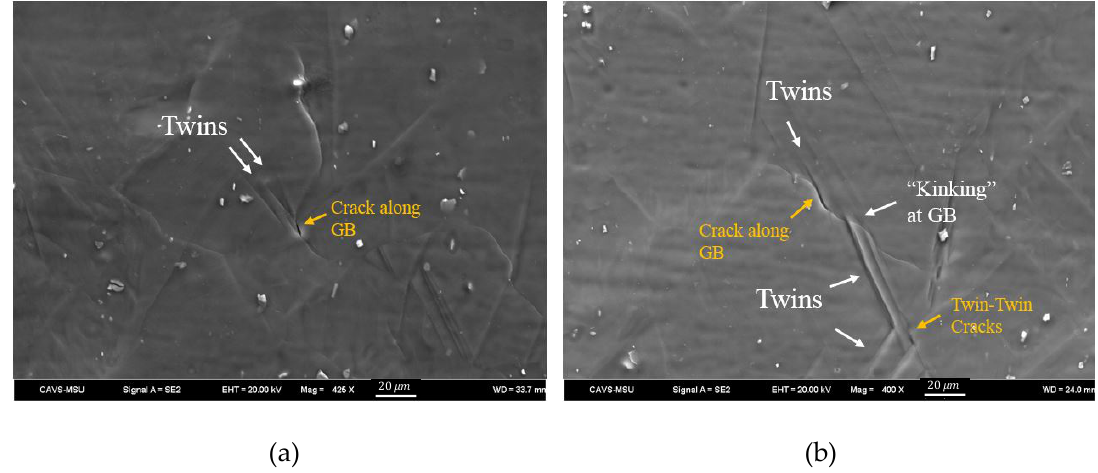
Figure 8. ( a ) Twin–grain boundary (GB) interactions leading to crack nucleation due to a lack of strain accommodation. ( b ) Proper accommodation of strain is found at the surface where GB emerges through “kinking”. However, a crack is formed at the GB from interactions with another twin. Cracks are also noted from twin–twin